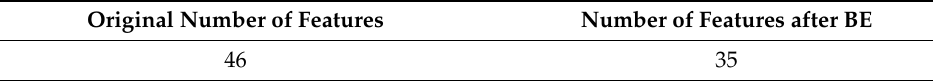
Table 5. Reduced features by Backward Elimination.